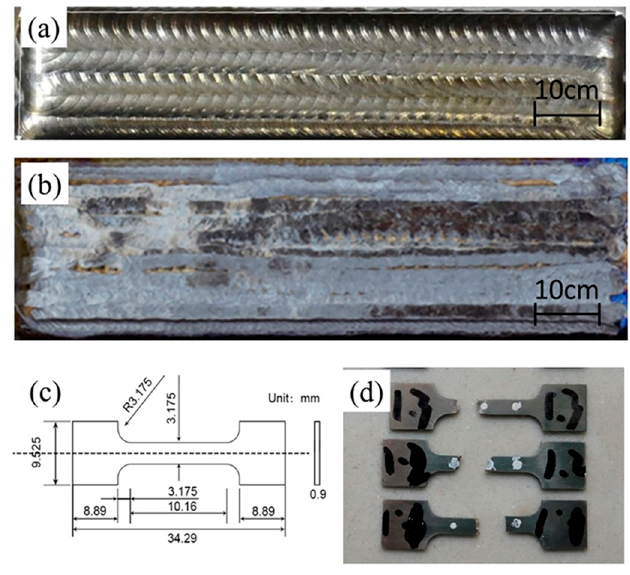
Figure 4. Optical image of the surface of ( a ) as-deposited and ( b ) post-UIT sample. ( c ) the dimensions of a typical tensile sample, ( d ) the sample after tensile test.